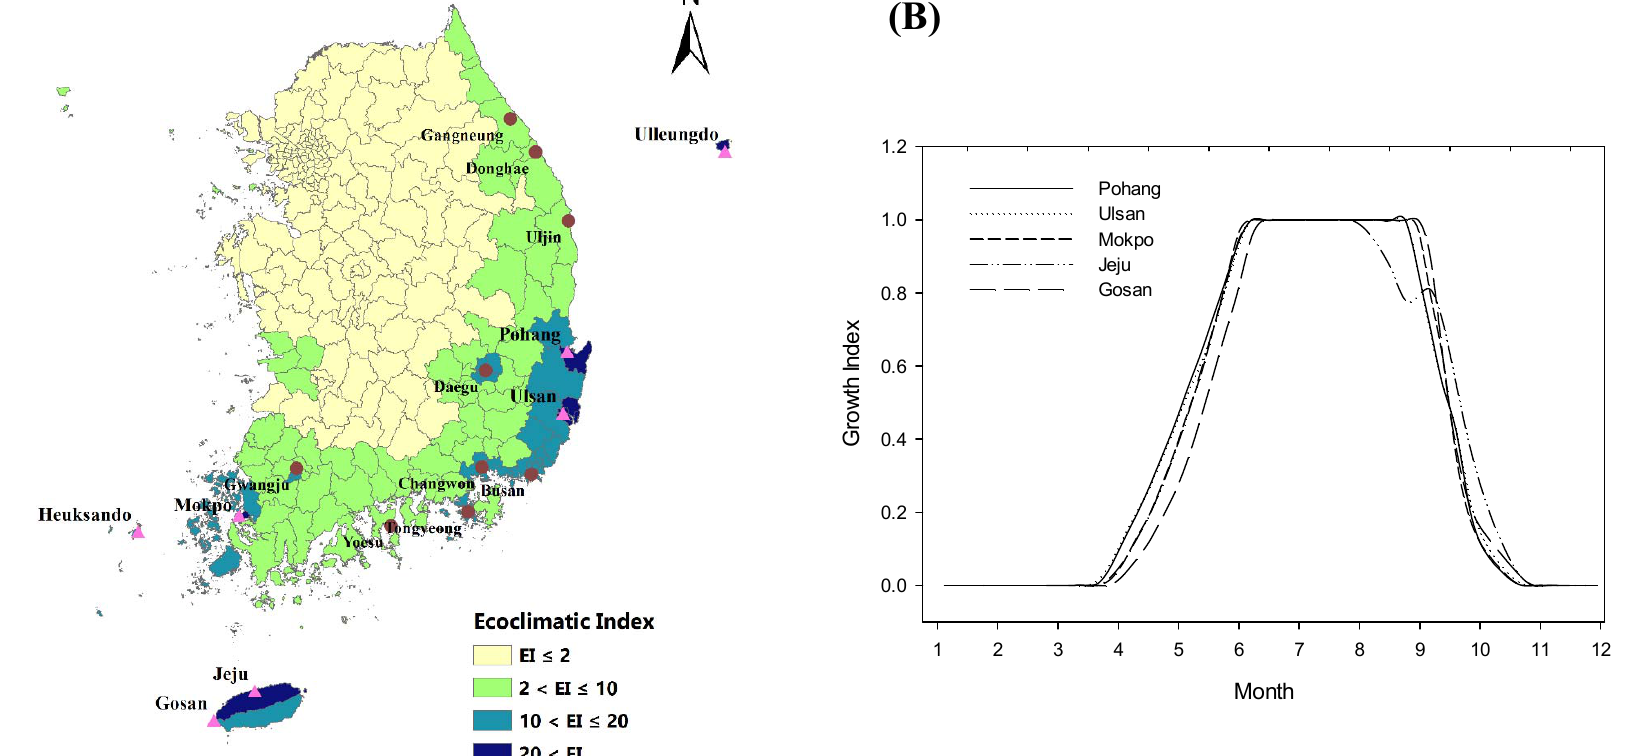
Figure 1. Map for climatic suitability represented by the Ecoclimatic Index (EI) under current climate with the main cities showing a high risk of the red imported fire ant invasion ( A ). Potential active seasons represented by the Growth Index in the 5 main risky cities ( B ). Brown circles and pink triangles mean cities with a EI value more than 10 and 20, respectively.